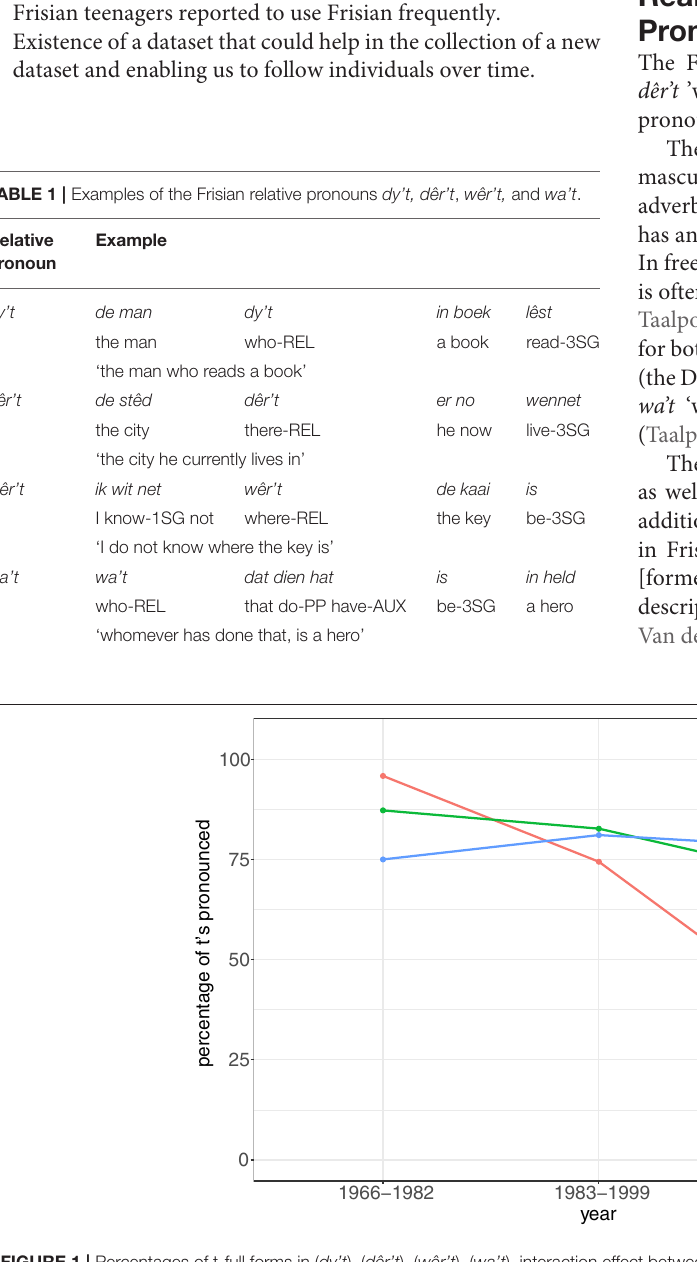
FIGURE 1 | Percentages of t-full forms in ( dy’t ), ( dêr’t ), ( wêr’t ), ( wa’t ), interaction effect between age of all speakers and broadcasting year ( n = 776, N = 266). Based on: Dijkstra et al. (2019, p.